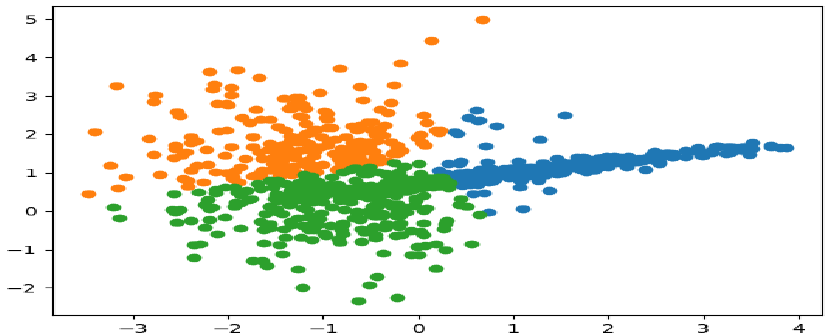
Figure 1. Simulated results for the two clusters showing two states of the sensor with 2 features.